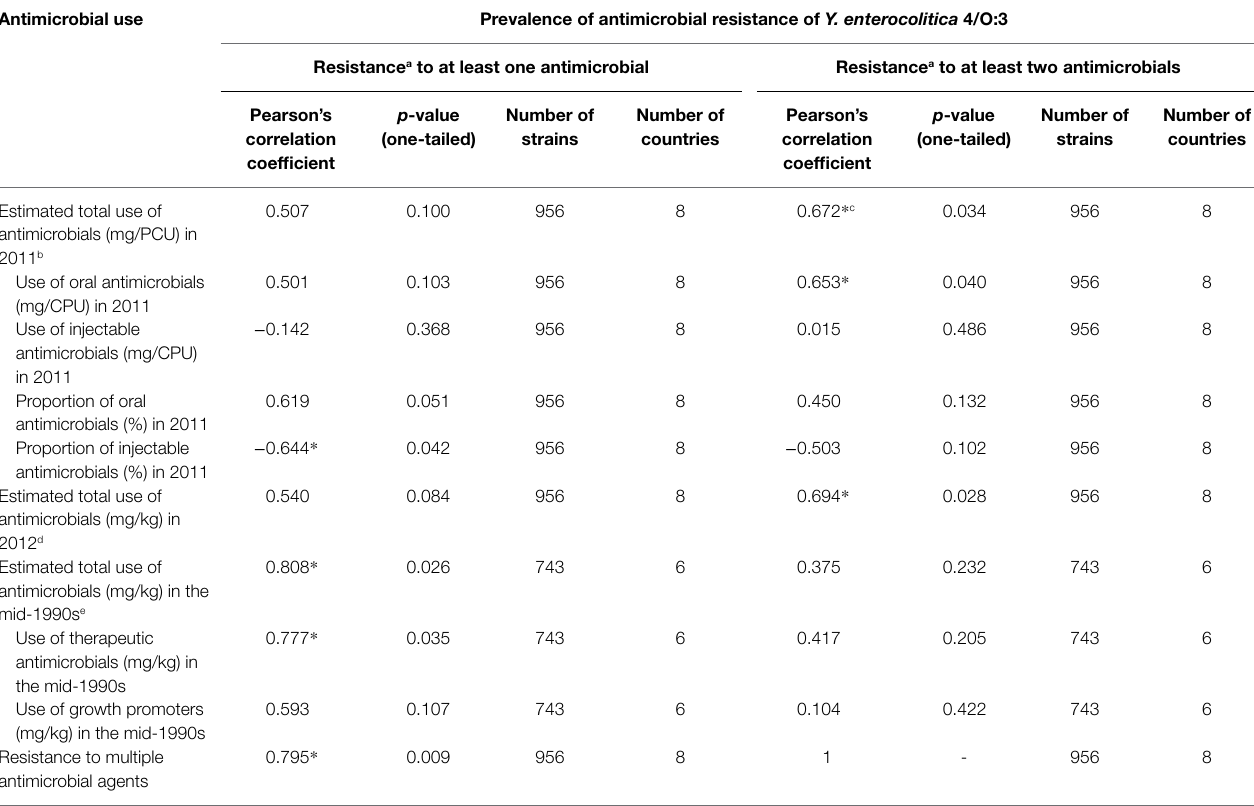
TABLE 5 | Correlation between antimicrobial use and resistance of porcine Yersinia enterocolitica 4/O:3 strains in Europe. Antimicrobial use Prevalence of antimicrobial resistance of Y. enterocolitica 4/O:3 Resistance a to at least one